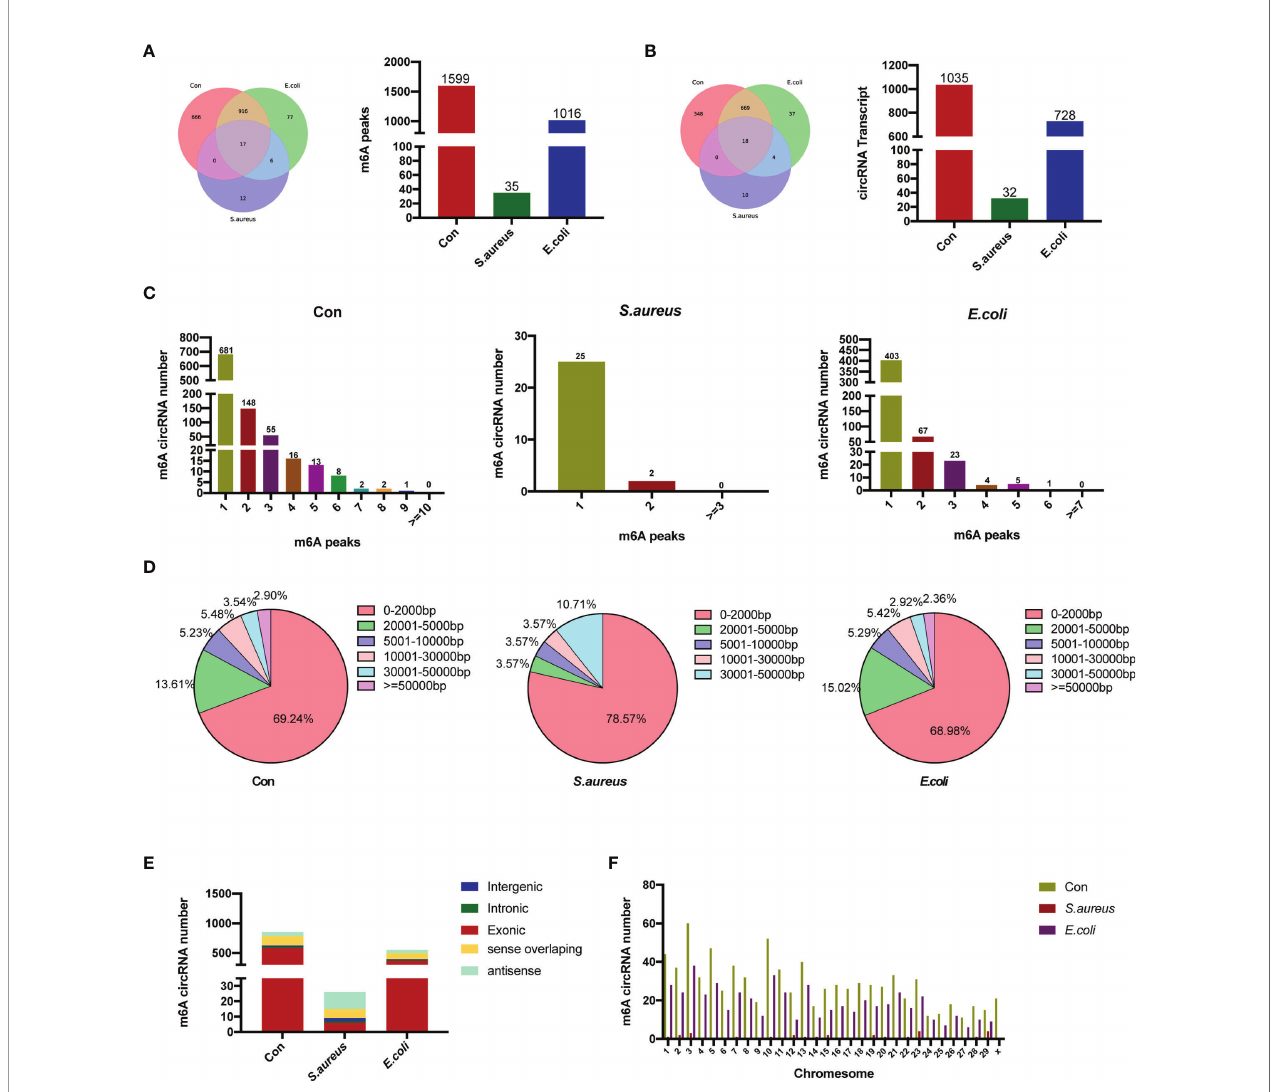
FIGURE 2 | Overview of m 6 A-modi fi ed circRNAs in MAC-T cells injured by S. aureus and E. coli . (A) Venn diagram and histogram displaying the speci fi c m 6 A peaks between the control group, S. aureus group, and E. coli group. (B) Venn diagram and histogram showing the speci fi c circRNA with m 6 A modi fi cation between the three groups. (C) The number of m 6 A peaks per circRNA in the three groups. (D) The length of m 6 A-modi fi ed circRNAs in the three groups. (E) The source of m 6 A- modi fi ed circRNAs in the three groups. (F) Chromosome